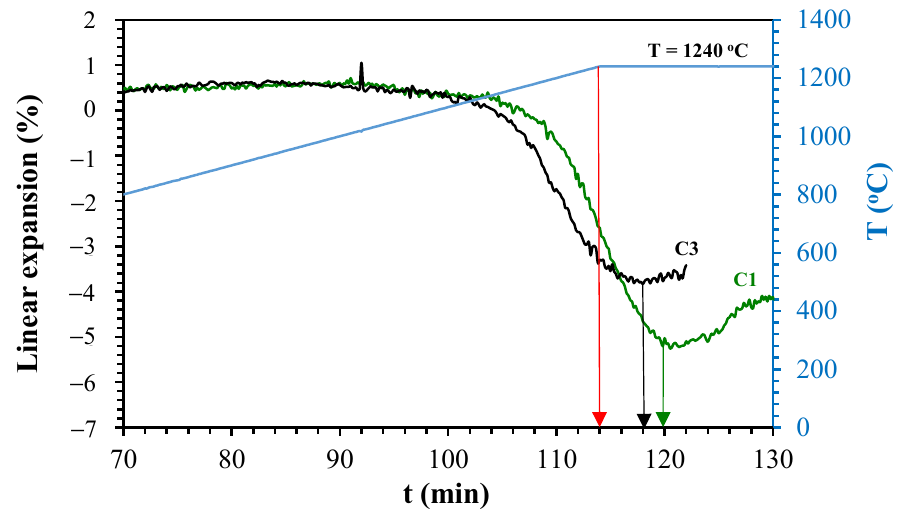
Figure 6. Linear expansion as a function of holding time of C1 and C3 at 1240 °C.